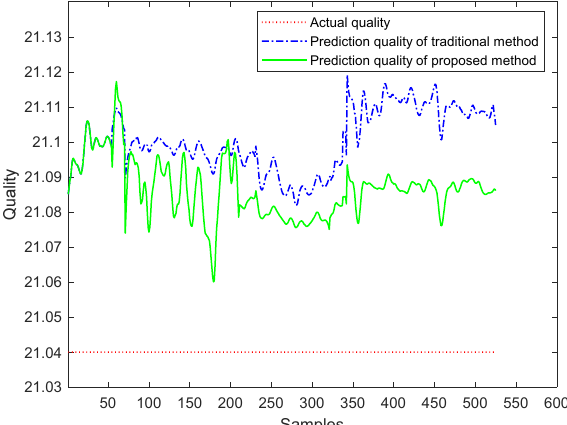
Figure 15. Multi-mode online prediction of mode 1.